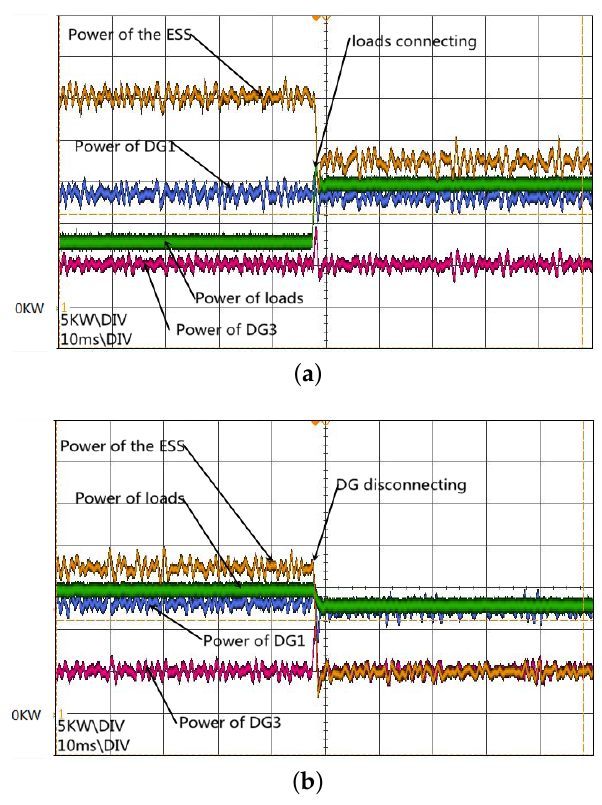
Figure 11. ( a ) Load connection and ( b ) DG disconnection of the control